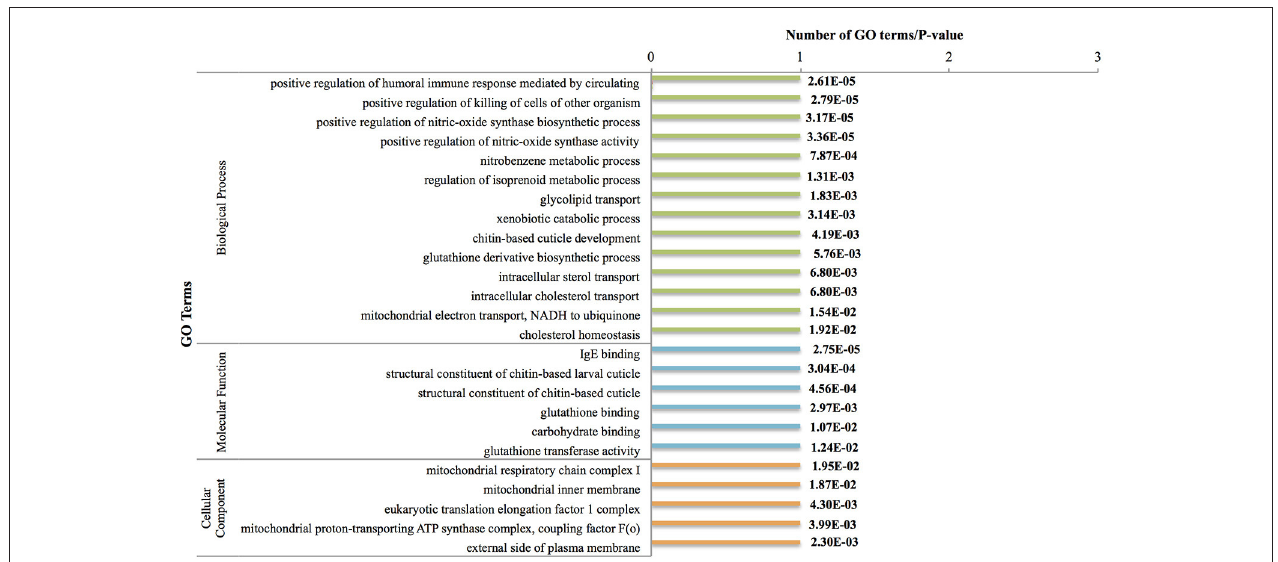
FIGURE 3 | Most frequent down-regulated GO terms between Nauplius VI and Cyprid. P -values are indicated on the right side. GO terms have been chosen based on hyper geometric test ( P < 0.01) and most frequent terms.